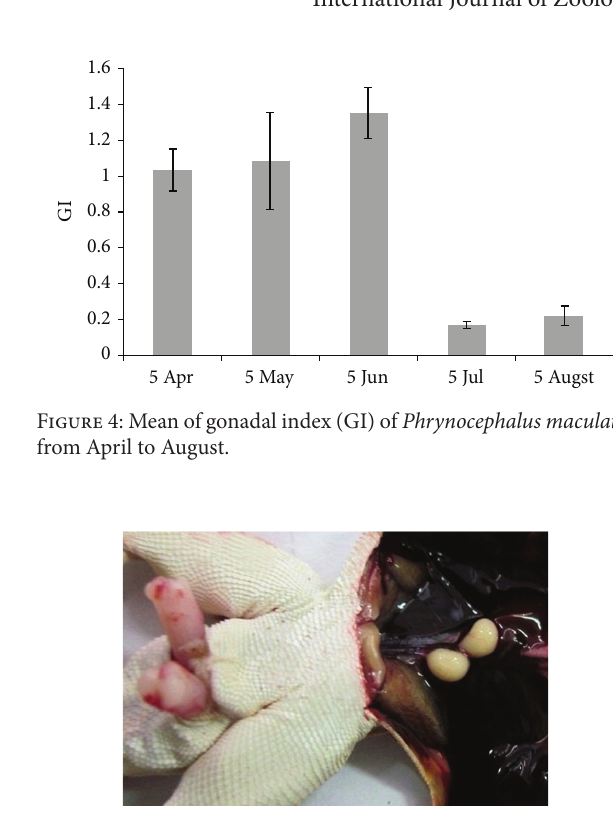
Figure 5: Hemipenis and testis of Phrynocephalus maculatus